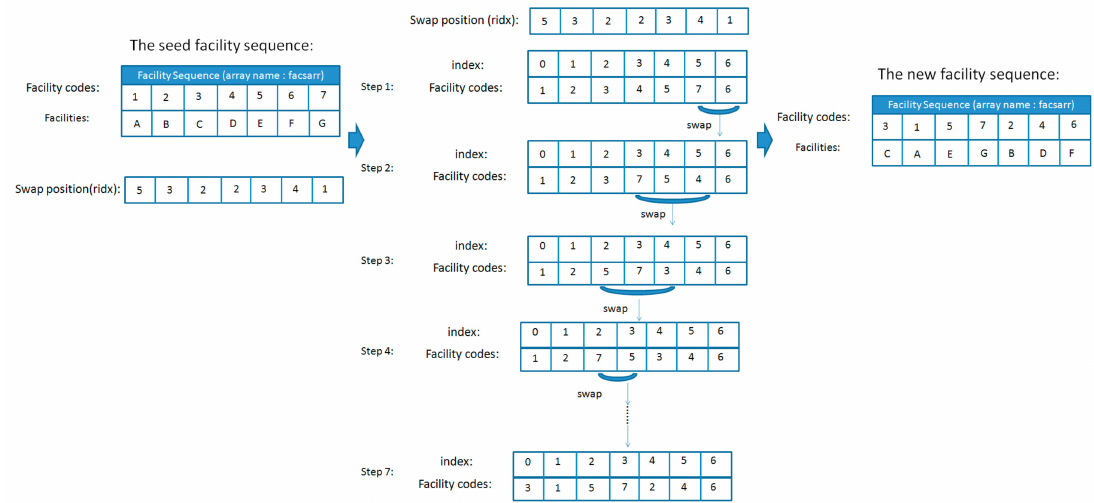
Figure 5. An example of the INI_FS2